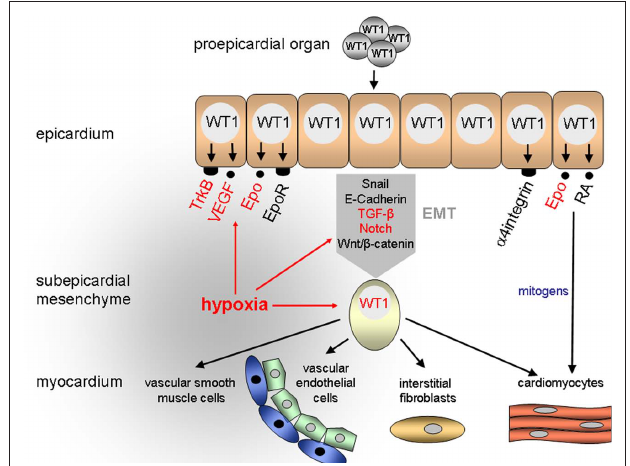
FIgure 1 | Proposed role of hypoxia and WT1 in the developing heart. A major function of WT1 is the control of epithelial-to-mesenchymal transition (EMT) of epicardial cells. Epicardium-derived mesenchymal cells give rise to vascular endothelial and smooth muscle cells as well as interstitial fibroblasts and cardiomyocytes in the heart. RA, retinoic